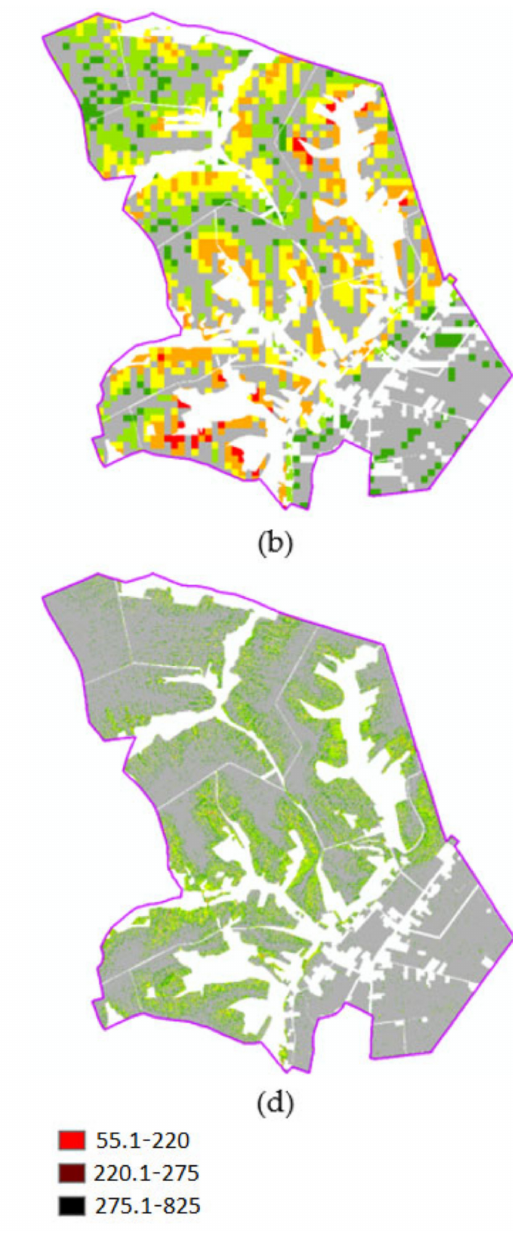
Figure A2. Visualisation of the total LS factor values (classes) calculated from SRTM ( a ), DTED2 ( b ), LPIS ( c ) and ISOK ( d ) for the Winiarki research